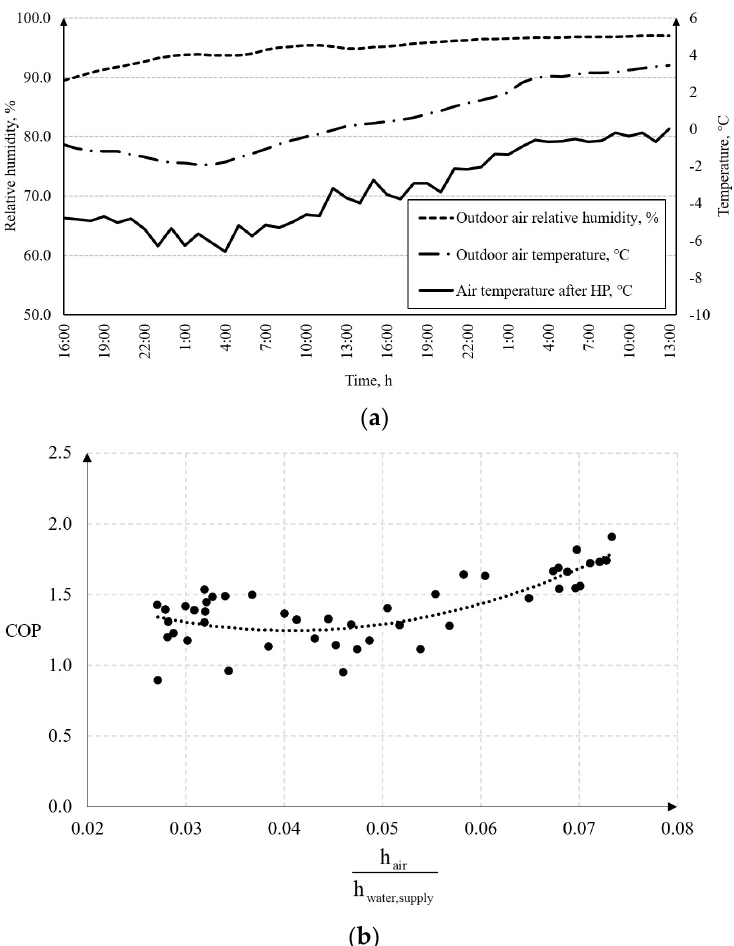
Figure 10. ( a ) Variation in ambient air parameters and temperature after ASHP evaporator; ( b ) variation in the COP depending on the ratio of enthalpies of ambient air and water supplied (15–17 December 2020).